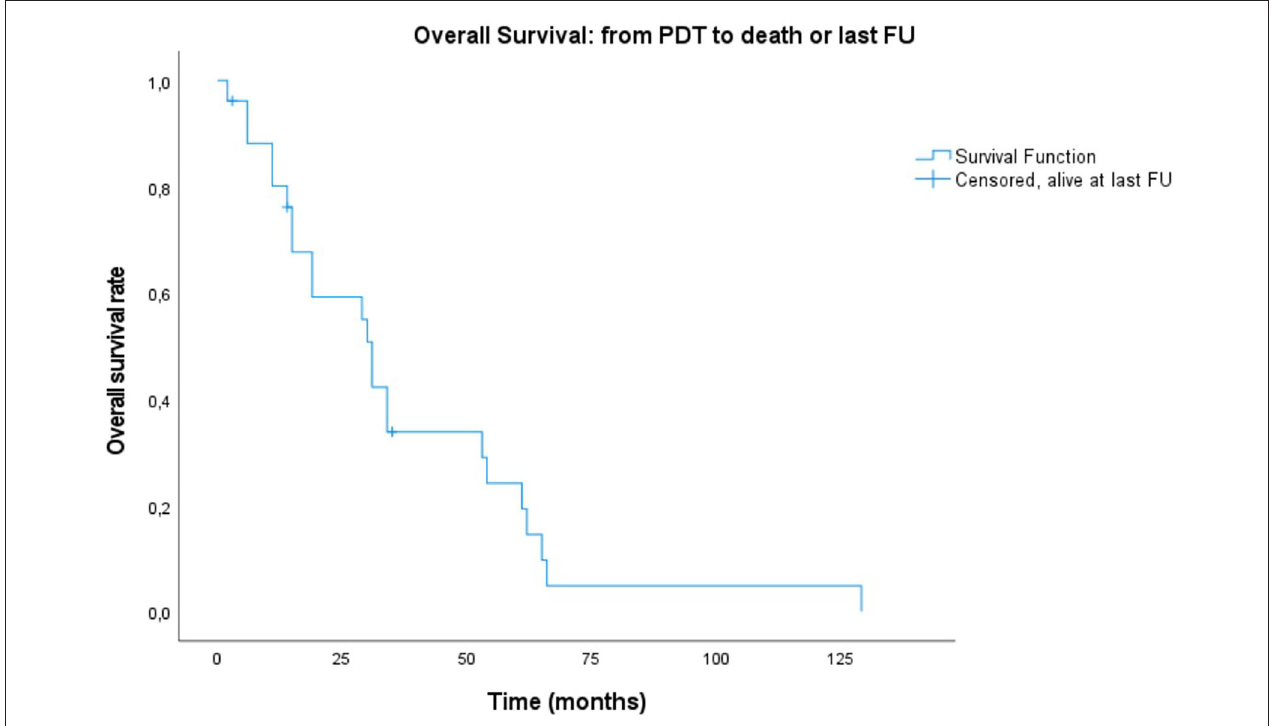
FIGURE 2 | Kaplan–Meier plot showing overall survival of PDT patients, starting from illumination date to endpoint defined as either overall death or alive at last follow-up